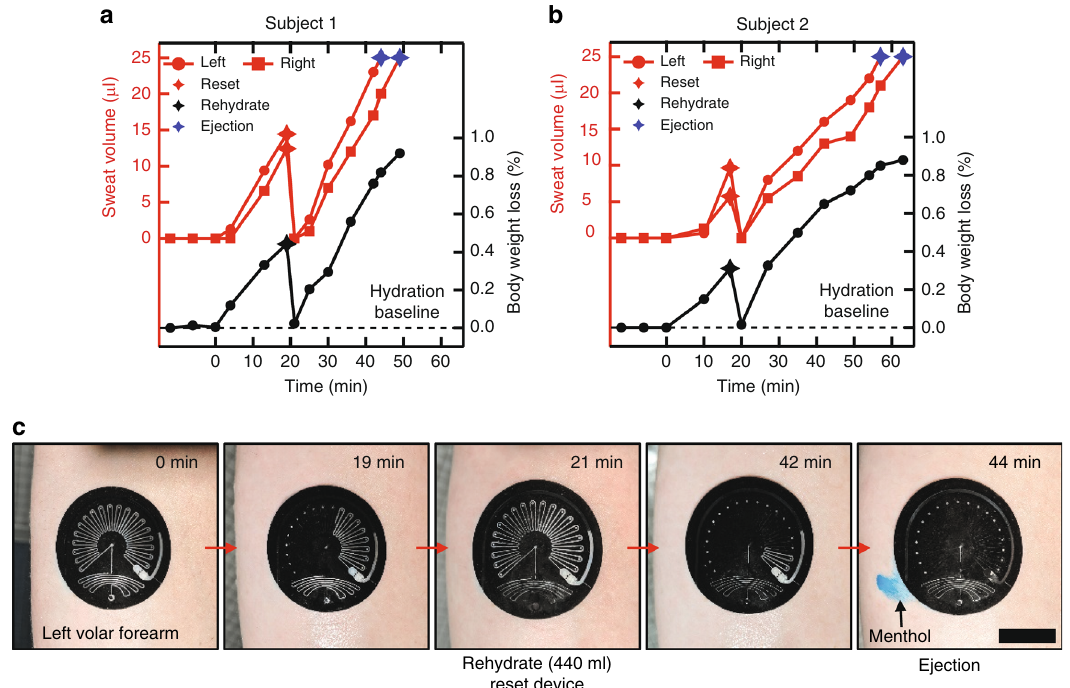
Fig. 6 Resettable sweat collection and chemesthetic ejection. Data from sauna trials for two subjects demonstrate the ability of these systems to operate in real world environments. Good correlation between epi fl uidic sweat collection and body weight loss is observed before and after resetting and rehydration for a Subject 1 and b Subject 2. c Representative images from the trial with Subject 1. Scale bar: 2